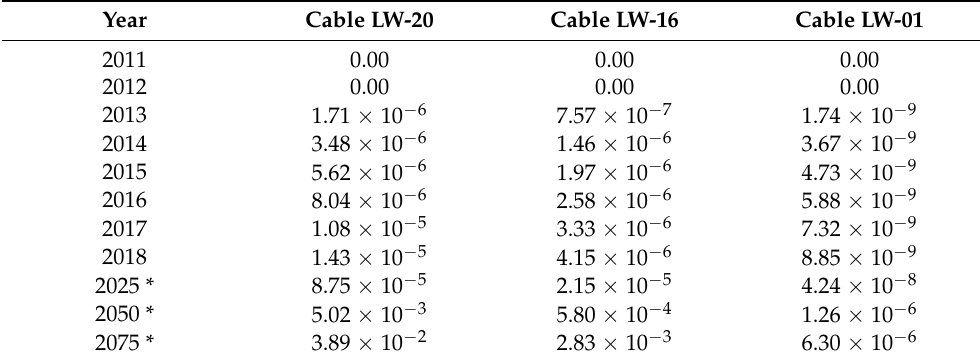
Table 13. Values of the failure accumulation parameter D .